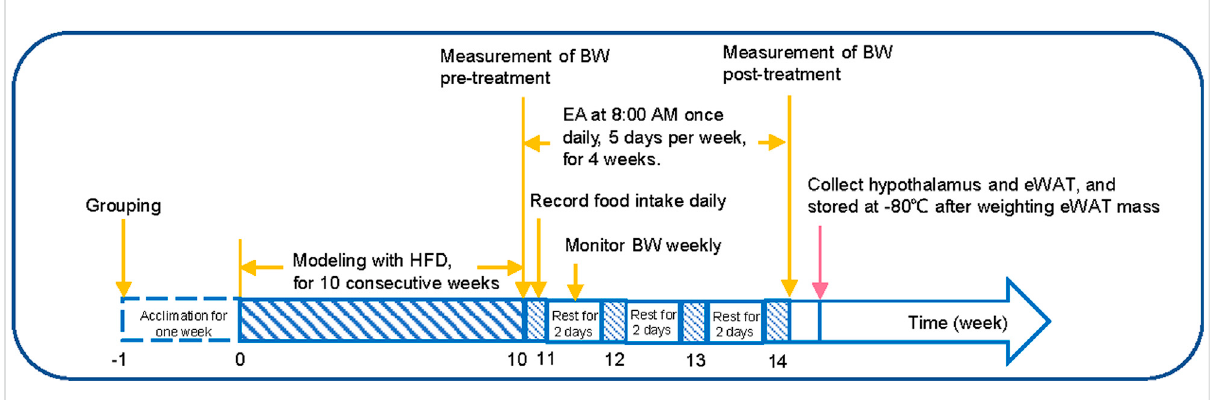
FIGURE 1 Experimental protocol. (1) week 0 – 10: the BW of the rats was monitored weekly; (2) week 11 – 14: the average food intake was recorded daily, and the BW of the rats was recorded on the last day of each week; (3) the day after week 14: the hypothalamus and adipose tissue samples were collected, and the eWAT mass was weighted. HFD, high-fat diet; EA, electroacupuncture; eWAT, epididymal white adipose